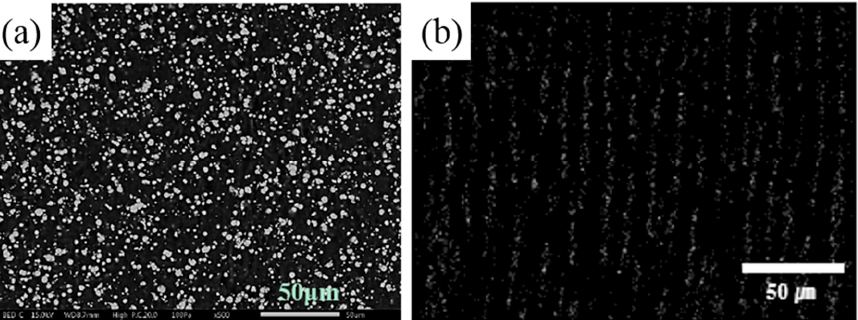
Figure 3. SEM images of the pure CI particles based isotropic MRE ( a ) [97] and anisotropic ( b ) MRE [104].